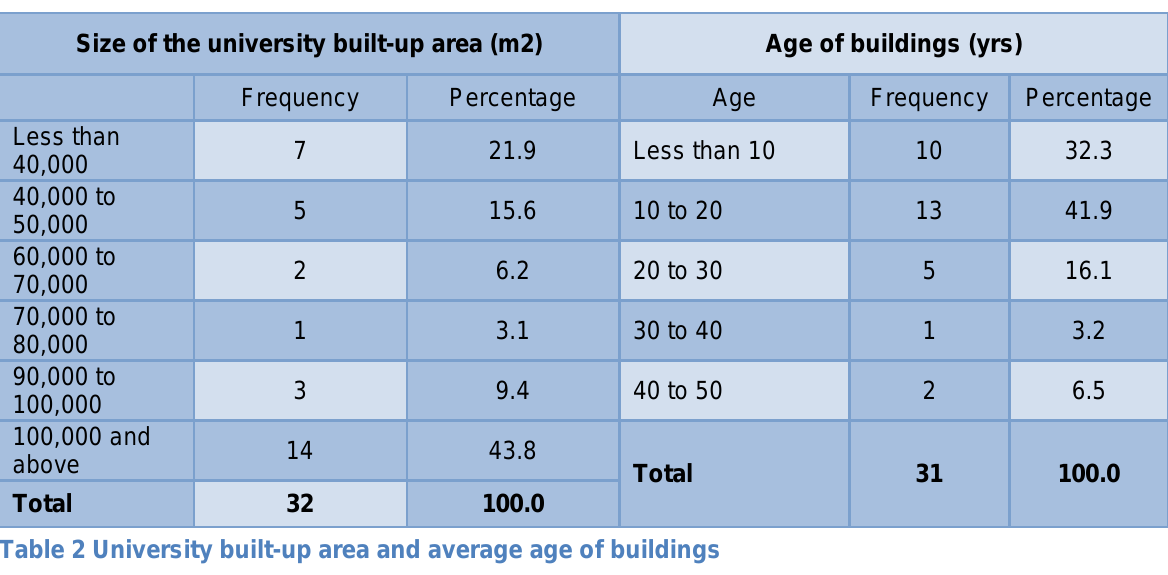
Criteria that influence maintenance